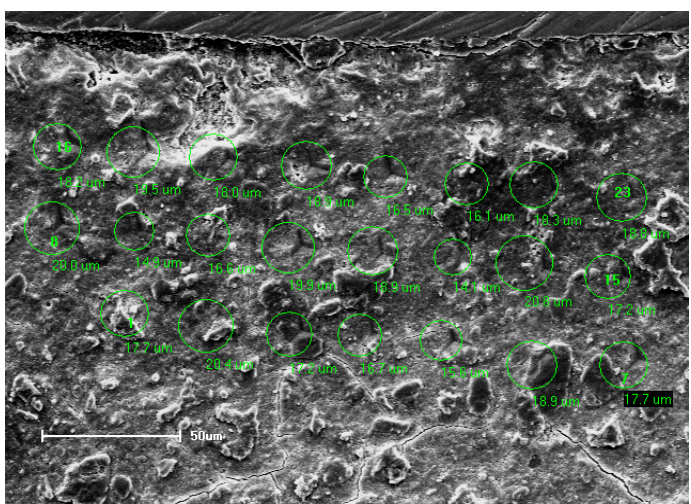
Figure 4. Micrograph (400X) of indentation matrix 1 located at the steel microfiber-paste interface showing all 24 indentation points ~30 µm from each other, distributed in 8 columns and 3 rows (24 points